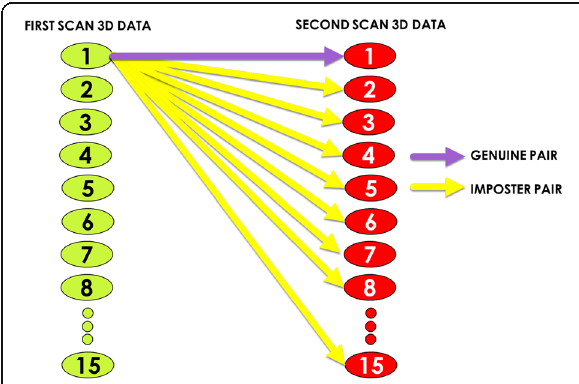
Fig. 2 A brief description of the genuine and the imposter pairs